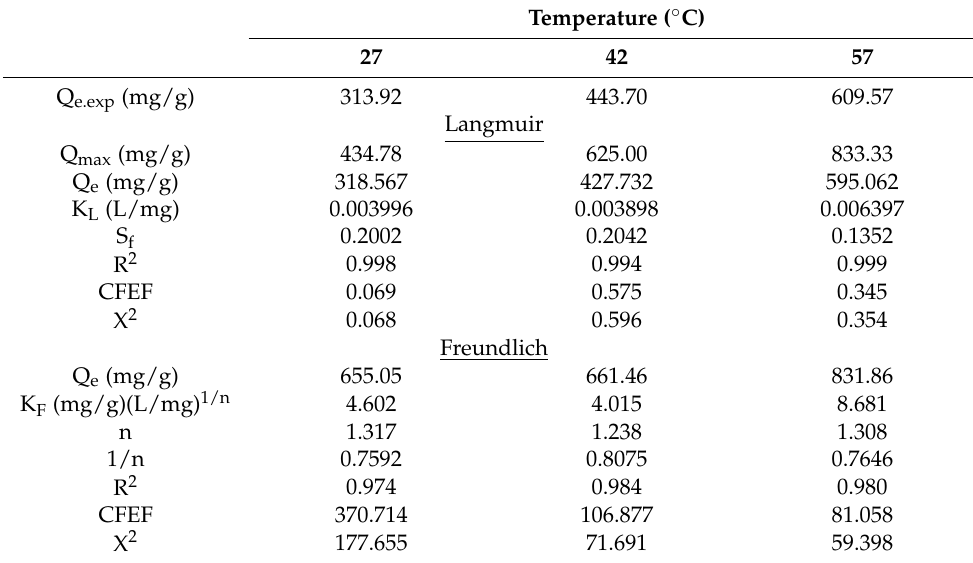
Table 4. Isotherm constants for CR adsorption onto